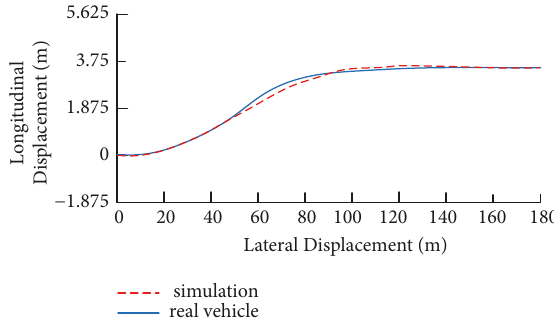
Figure 12: Comparison of vehicle planning trajectory and actual trajectory.